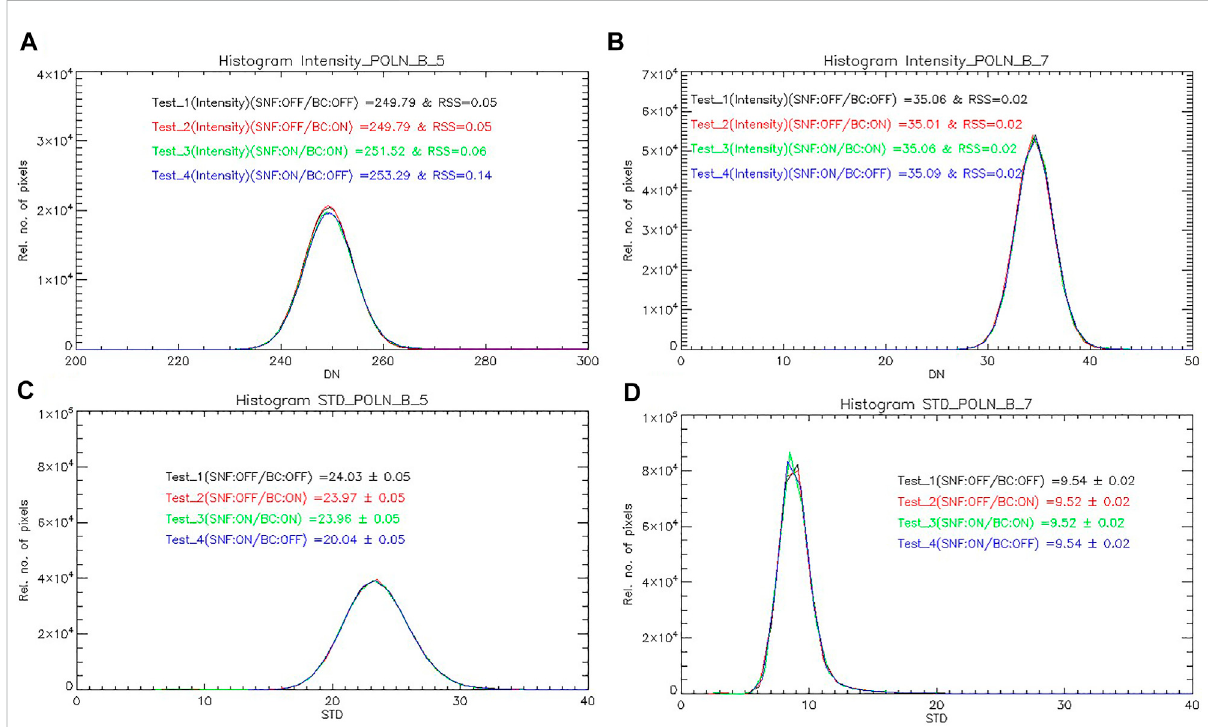
FIGURE 5 Analysisofthein fl uenceoftheSpuriousNoiseFilterandBlemishCorrectiononthesensor.Panel (A) isthehistogramofthemeanintensityofB5 (Global Shutter, Cooling OFF) for POLN. Likewise, (B) is for B7 (Rolling Shutter, Cooling OFF). Panel (C,D) are histograms for the standard deviation (STD) ofB5 and B7,respectively. Test_1 stands for fi lterOFF, correction OFF. Test_2 represents fi lter OFF, correction ON. Test_3 expresses fi lter ON, correction ON. Test_4 means fi lter ON, correction